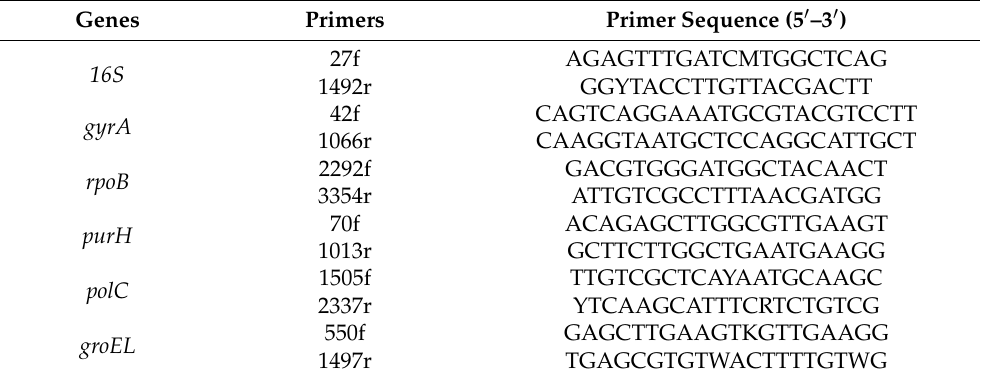
Table 1. Primers used for PCR amplification.